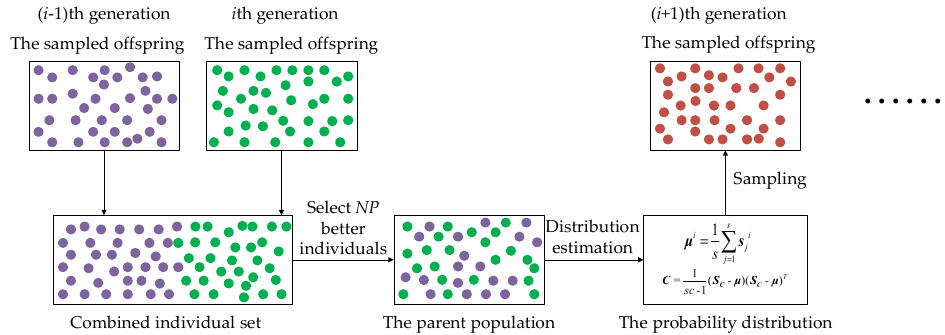
Figure 3. The process of the cross-generation individual selection strategy.